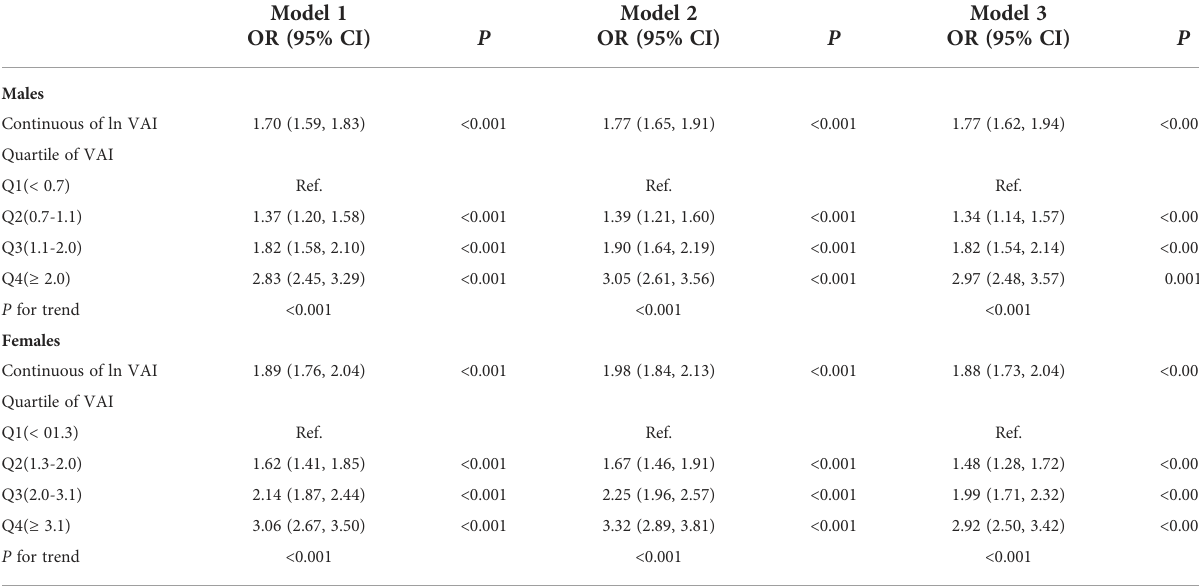
TABLE 3 Odds ratios and 95% CIs for hyperuricemia according to VAI as continuous variables and